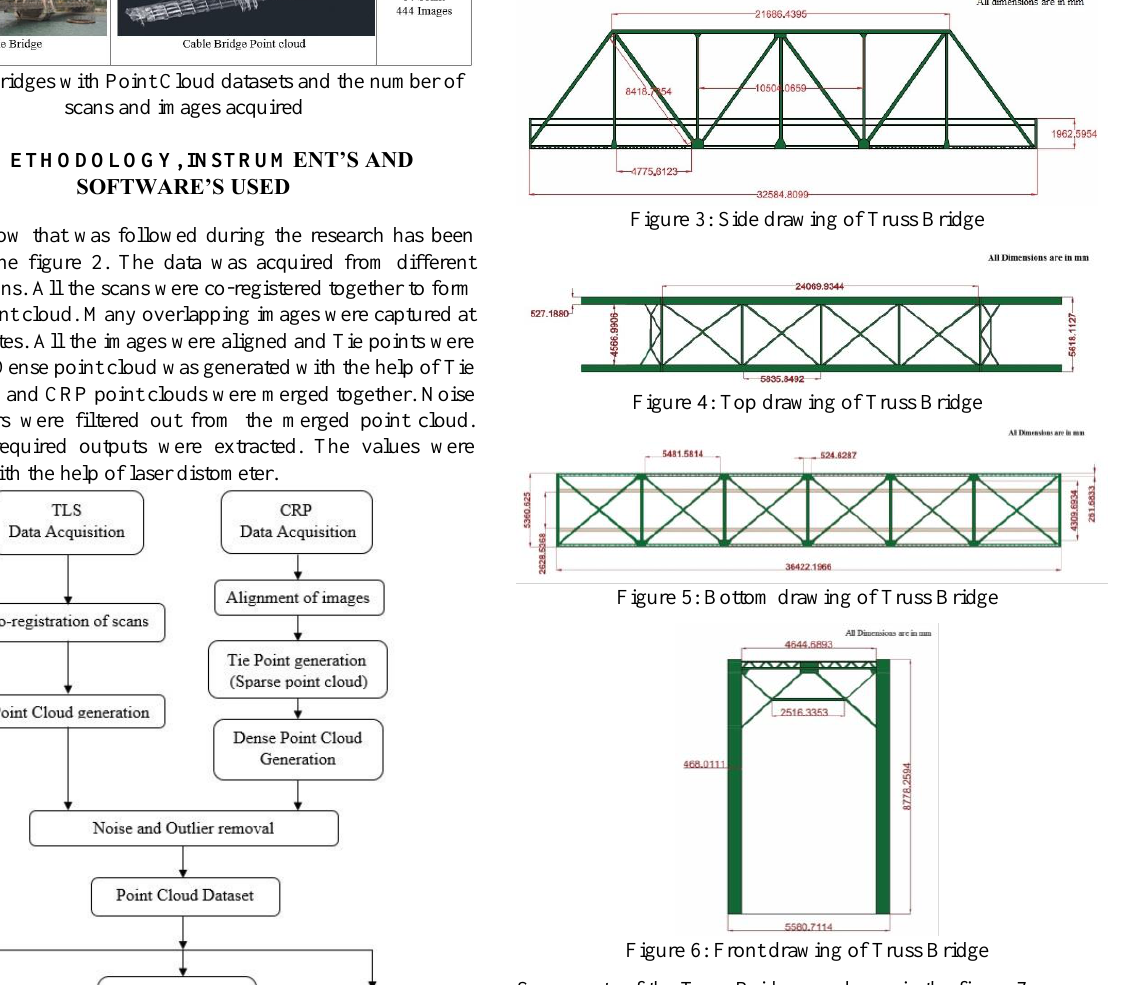
Figure 3: Side drawing of Truss Bridge